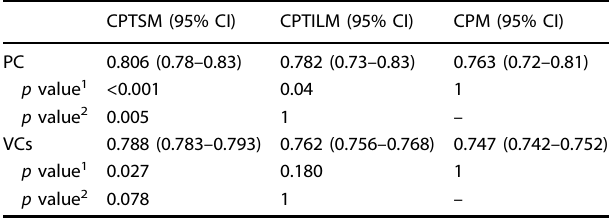
Table 3. AUCs of models for pCR prediction in the primary and validation